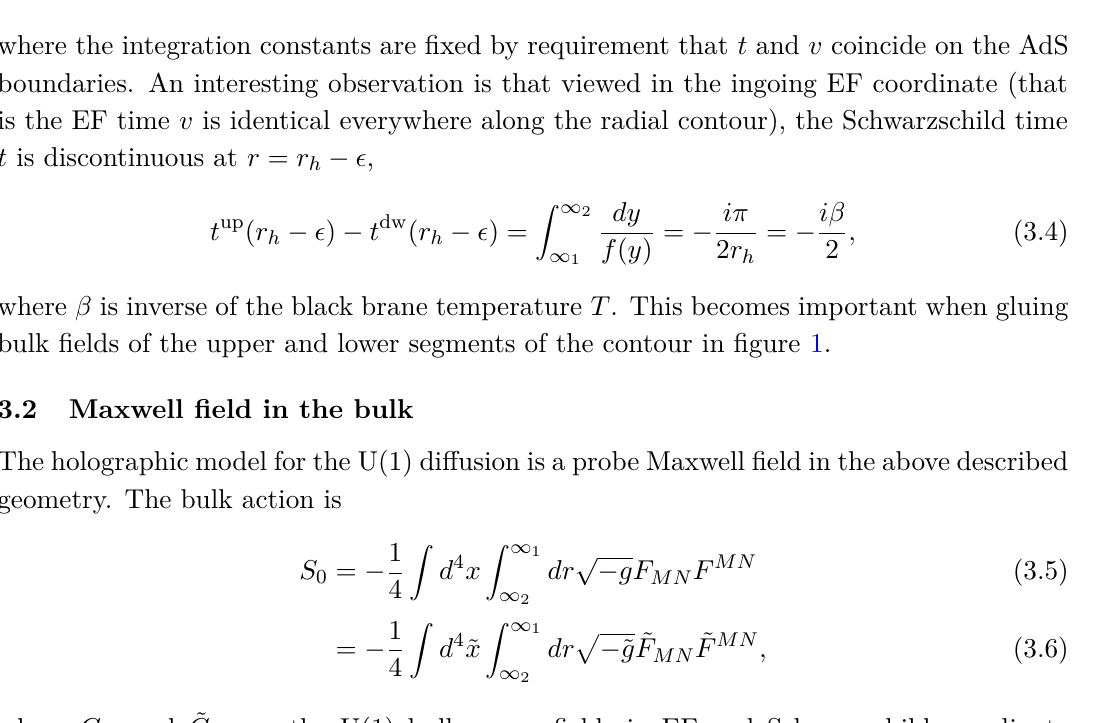
Figure 1 . The holographic SK contour of [60]: the complexified radial coordinate analytically continued around the event horizon r = r . The dashed arrows indicate that the horizontal segments h are infinitesimally close to the real